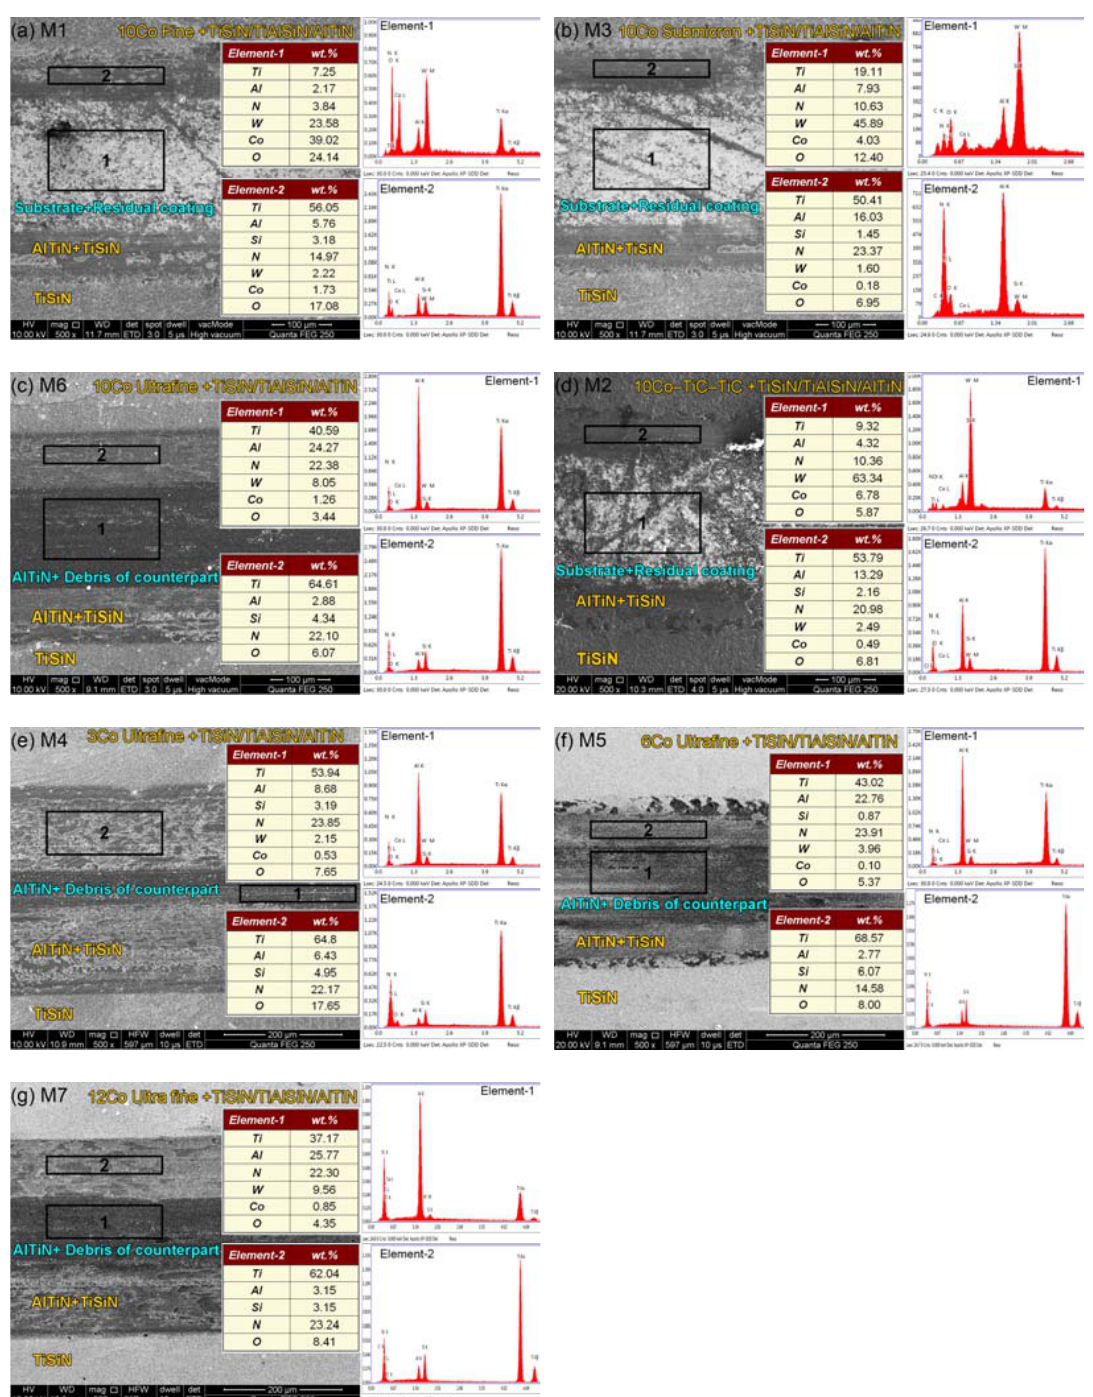
Figure 5. SEM images and EDS analysis results of the wear tracks of coated cemented carbides with different substrates: ( a ) M1, ( b ) M3, ( c ) M6, ( d ) M2, ( e ) M4, ( f ) M5, ( g ) M7.